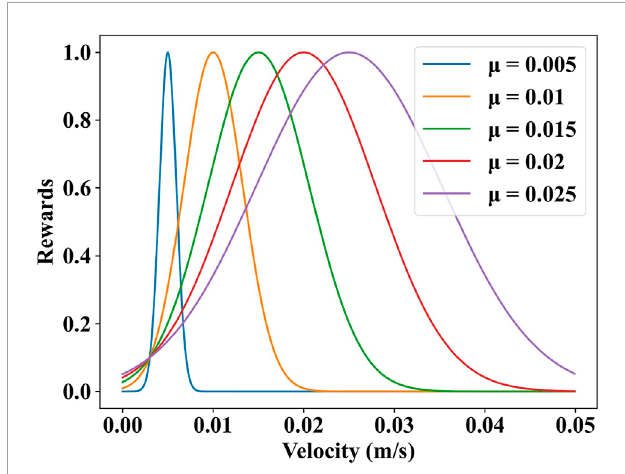
FIGURE 3 The relationship between velocity and reward. μ is the target velocity of snake robots. The position of the margin point is (0.003, 0.1).